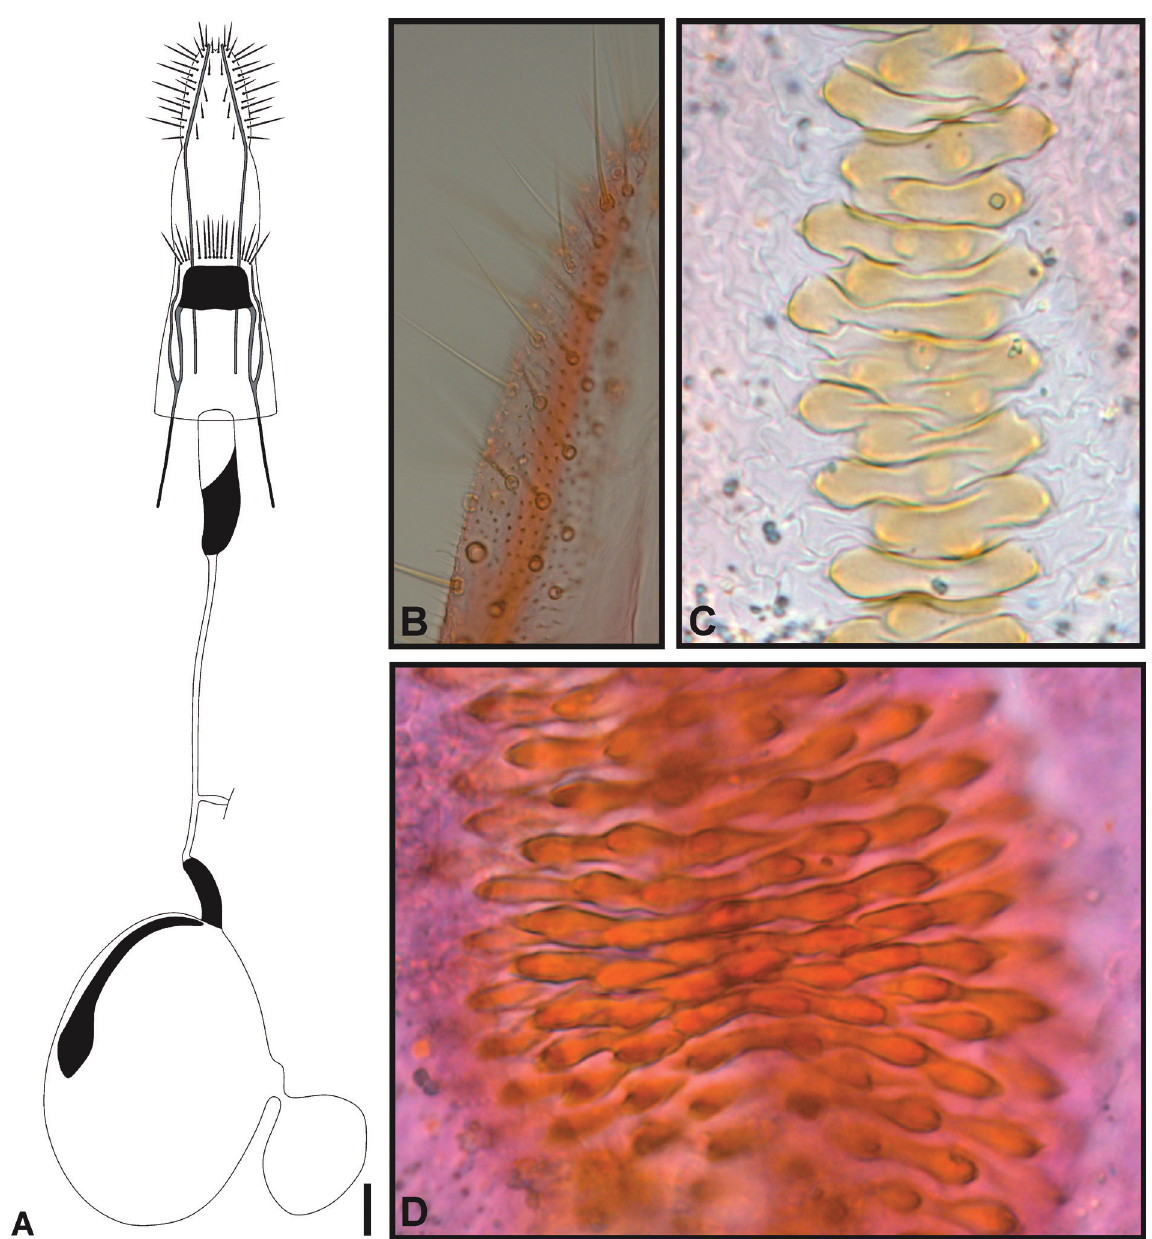
Fig. 6. Female genitalia of Helioandesia tarregai gen. et sp. nov., ♀, paratype (IDEA-LEPI-2020-024) A . Female genitalia, ventral view. B . Papillae analis. C . Ornamentation of the proximal part of the signum. D . Ornamentation of the distal part of the signum. Scale bar: 0.1